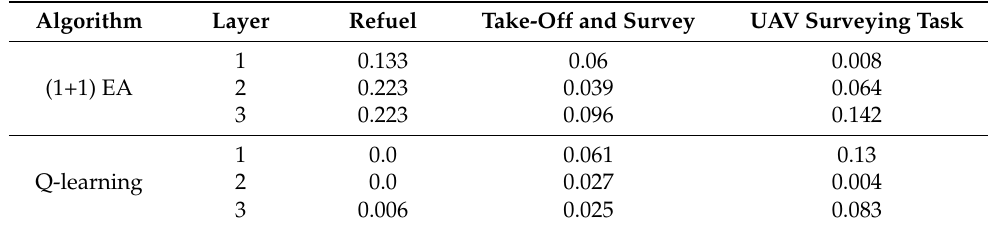
Table 4. The standard deviation of the subtask performance of each layer for complementary layered